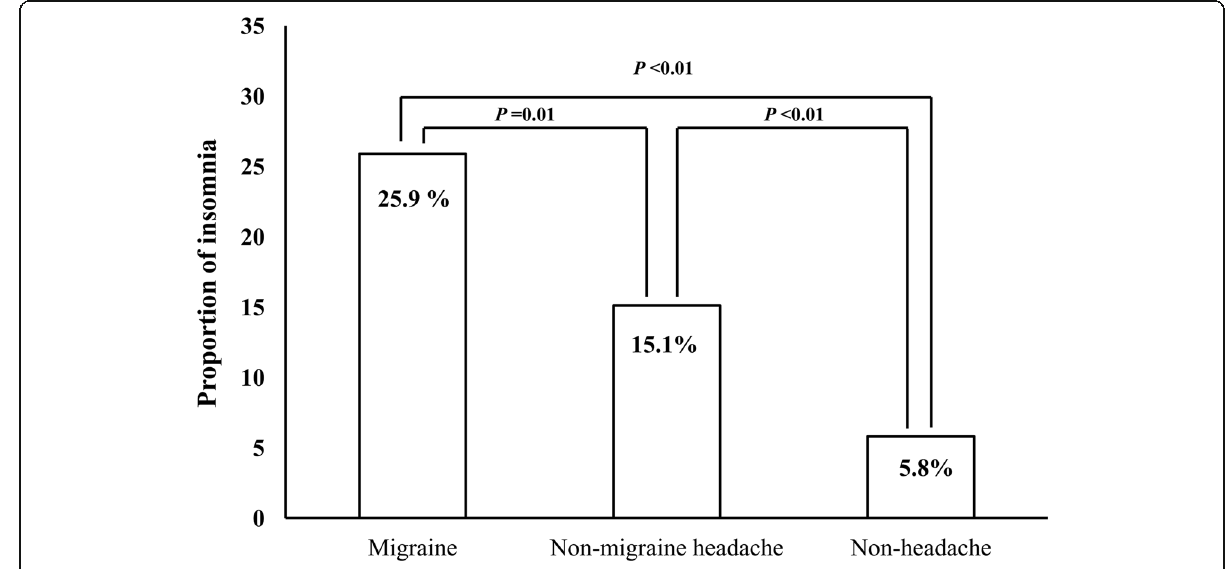
Fig. 3 Comparison of the prevalence of insomnia according to headache